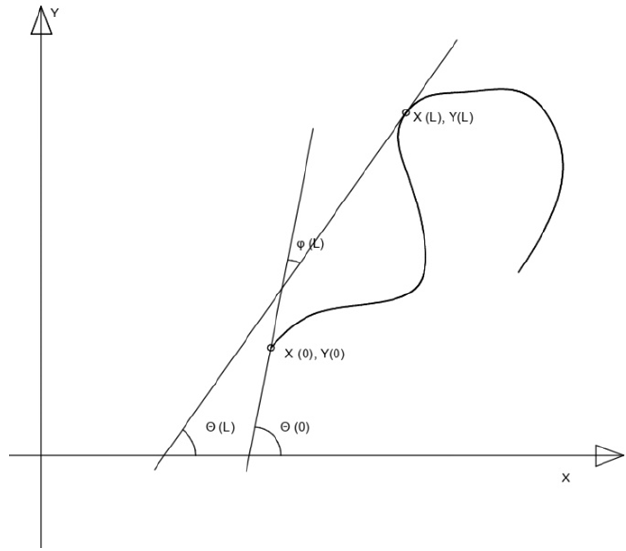
Figure 2. Angles in cumulative angular function (redrawn) [30].